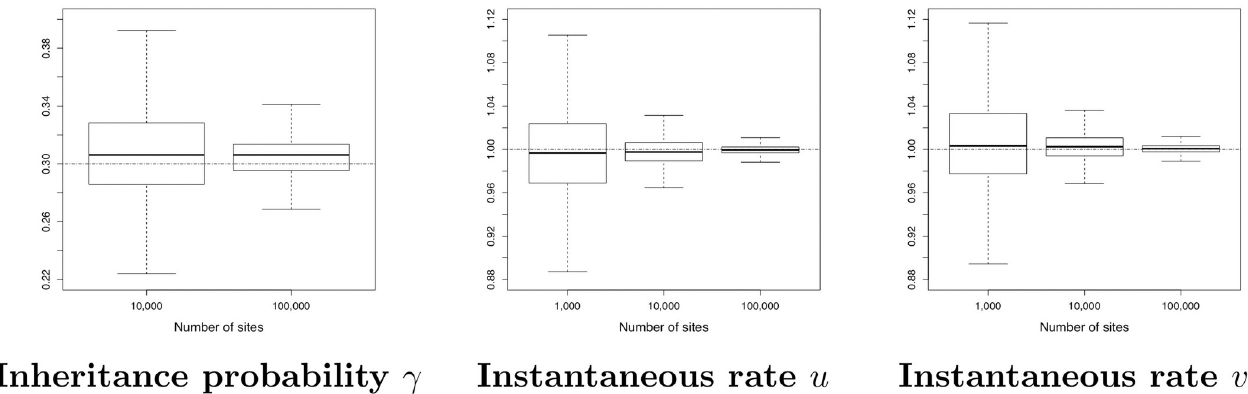
Fig 11. Estimated inheritance probability and instantaneous rates for network A (see Fig 7), as a function of the number of sites. True values are given by the dashed horizontal lines. Same framework as in Fig 10.